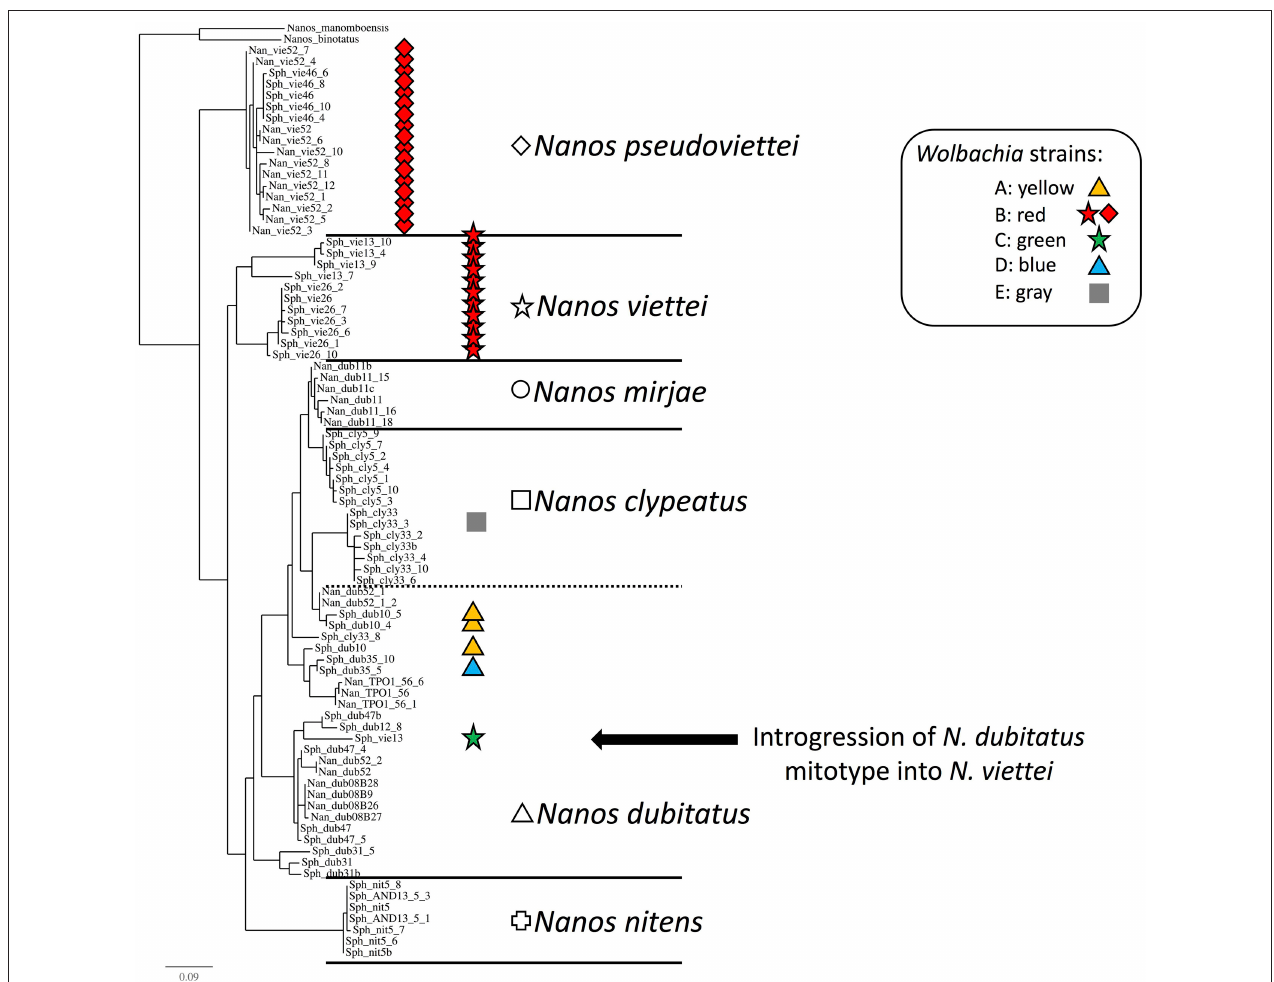
FIGURE 3 | Phylogenetic tree of the Malagasy dung beetles based on the COI mitochondrial gene. Shapes are specific to host species, while colors inform on the Wolbachia infection status of the samples. (Cross): Nanos nitens , (Square): N. clypeatus, (Circle): N. mirjae, (Triangle): N. dubitatus, (Diamond): N. pseudoviettei, and (Star): N. viettei . (Yellow): strain A, (Red): strain B, (Green): strain C, (Blue): strain D, (Gray): strain E, and (White): Uninfected. The uncharacterized strain detected in three N. dubitatus is not included here. Nanos binotatus and N. manomboensis COI sequences from GenBank were used as outgroup for the tree. Introgression of N. dubitatus mtDNA in N. viettei is highlighted by the black